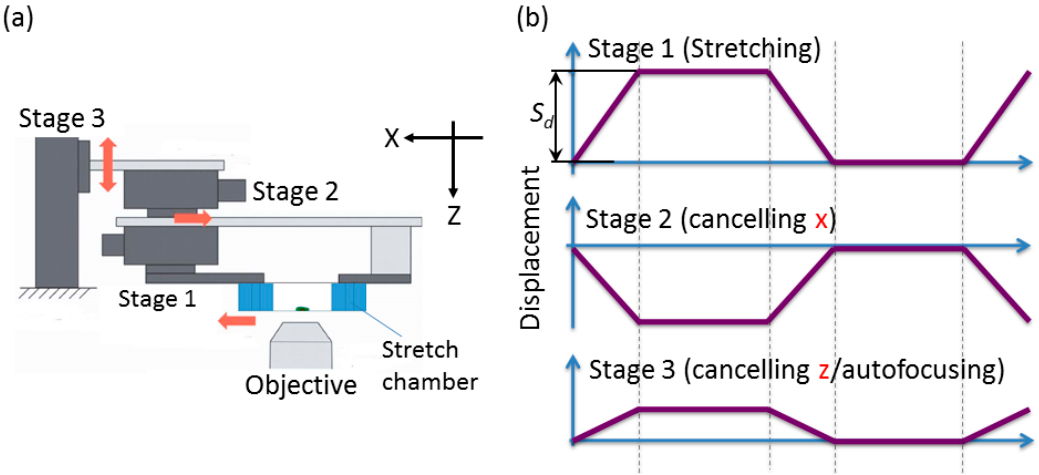
Figure 2. Basic concept of the stretching system for real-time compensation. ( a ) Three motorized stages for chamber stretching (stage 1), and compensation in the horizontal (stage 2) and vertical (stage 3) directions, respectively. ( b ) The timing chart for compensation.